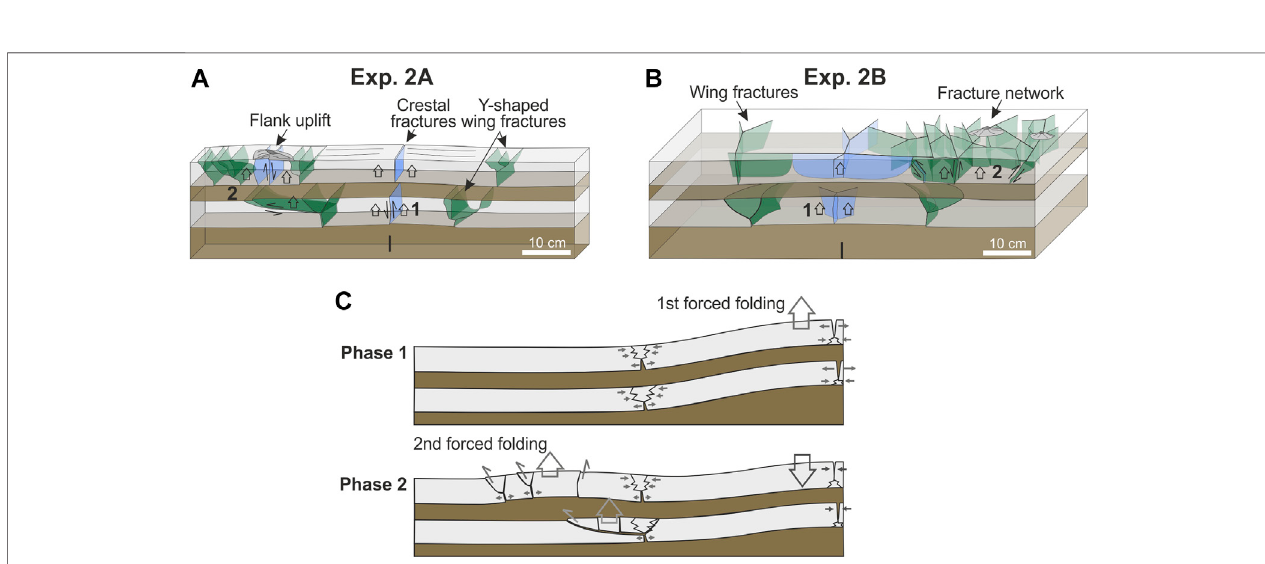
FIGURE 13 | Interpretive sketches showing wing fractures (green) and crestal fractures (blue). For the 3D experiment 2B, the half-width of the box is shown. (A) Exp.2A: an additional fracture network due to forced folding developed in the upper cover layer. (B) Exp.2B: Breakthrough of fractures occurred at the fl anks of the centralforcedfoldinthelowercoverlayer.Notethatpositionsandshapeoffracturesinthelowercoverlayerarespeculative. Theyweresketchedinanalogytoresultsof the 2D experiment 2A. (C) Two-stage evolution of principal fracture evolution shown for the left half of the model. Phase 1: Tensile and compactive failure in the central forced above the needle valve. Phase 2: shear failure leads to breakthrough of the wing fractures and a second sequence of forced folding and fracture breakthrough occurs in the upper cover layer.